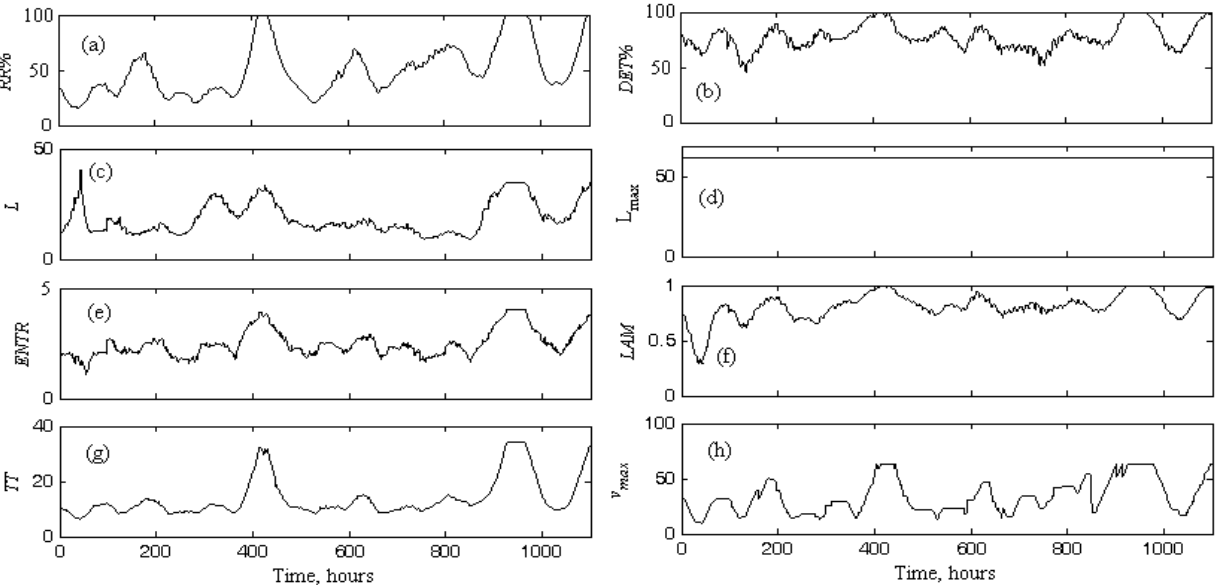
Figure 13. RQA measures for wind power (a) RR %, (b ) DET %, (c) L , (d) Lmax , (e) ENTR , (f) LAM %, (g) TT, and (h) Vmax .